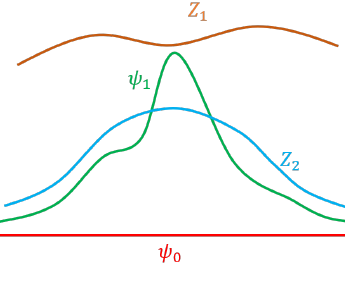
Fig. 6: Subsolutions ψ 0 , ψ 1 and supersolutions Z 1 , Z 2 .